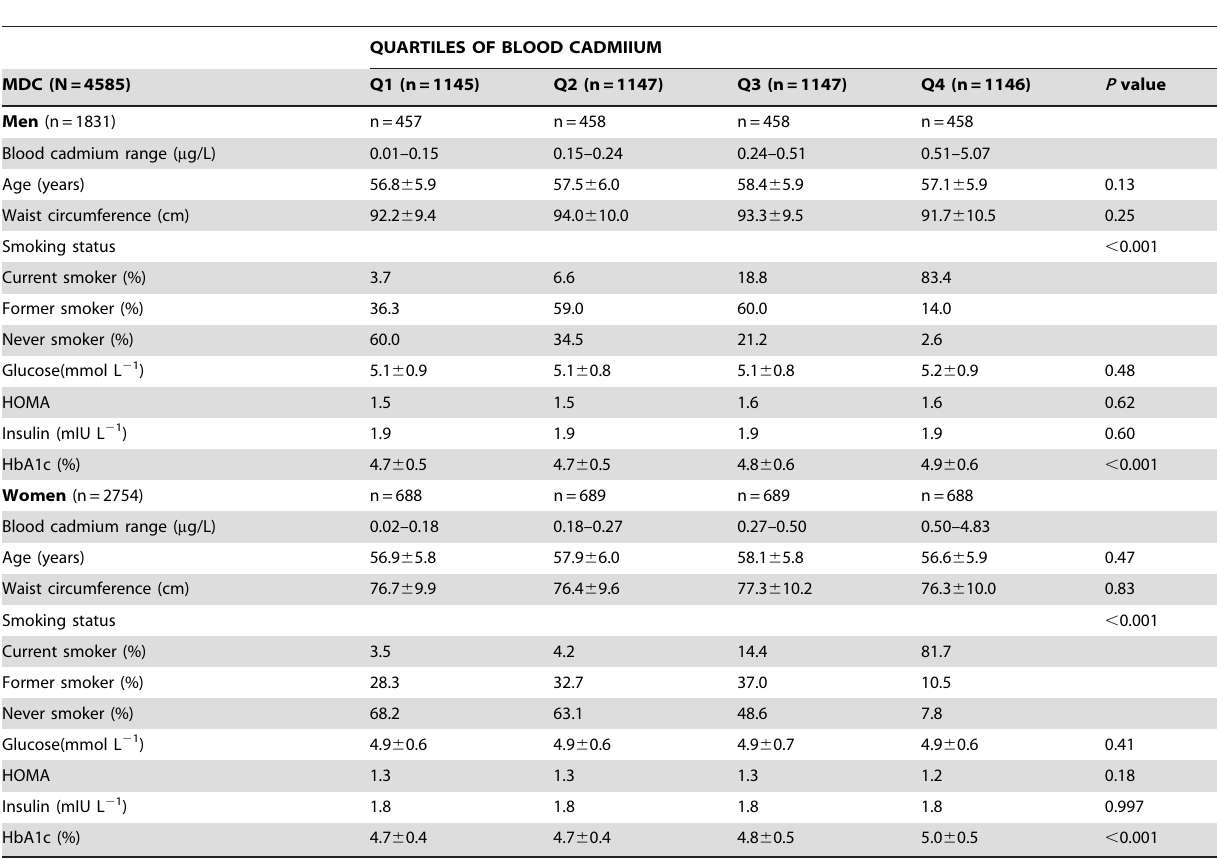
Table 1. Baseline Characteristics for Malmo¨ Diet and Cancer (MDC-CV) cohort in relation to quartiles (Q1–Q4) of cadmium in